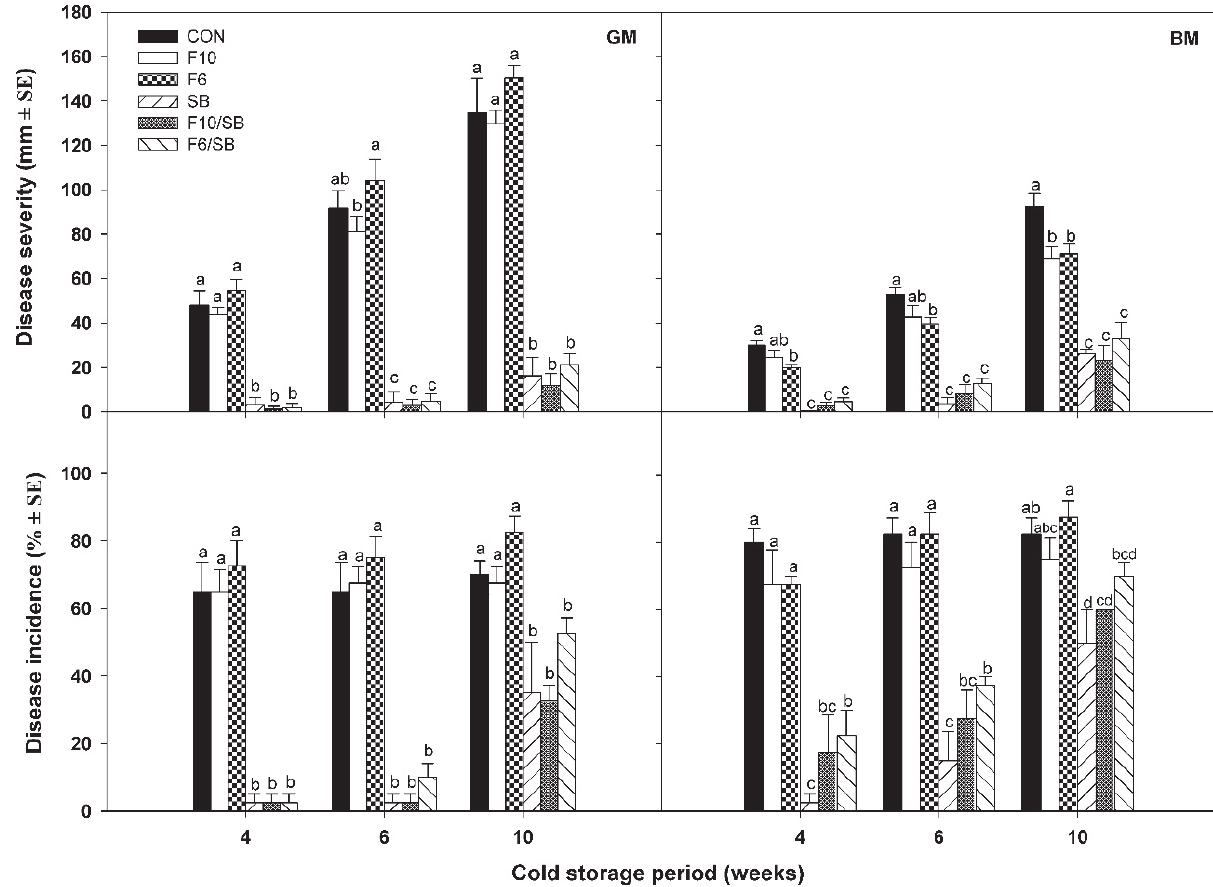
Figure 4. Mean severity and incidence of green mould (GM) or blue mould (BM) on ‘Valencia’ oranges artificially inoculated, respectively, with Penicillium digitatum or P. italicum , then coated 24 h later and cold-stored for 4, 6 and 10 weeks at 5°C and 90% RH. Treatments applied were: control (CON) = uncoated (immersion in water), F10 coating, F6 coating, 2% sodium benzoate (SB) aqueous solution (w/v), F10/SB coating, or F6/SB coating (see Table 2 for coating composition). For each disease and incubation period, columns accompanied by different letters are significantly different (Fisher’s protected LSD test; P < 0.05). Vertical lines above columns indicate standard errors. Inci- dence values were arcsine-transformed before statistical analyses. Non-transformed means are